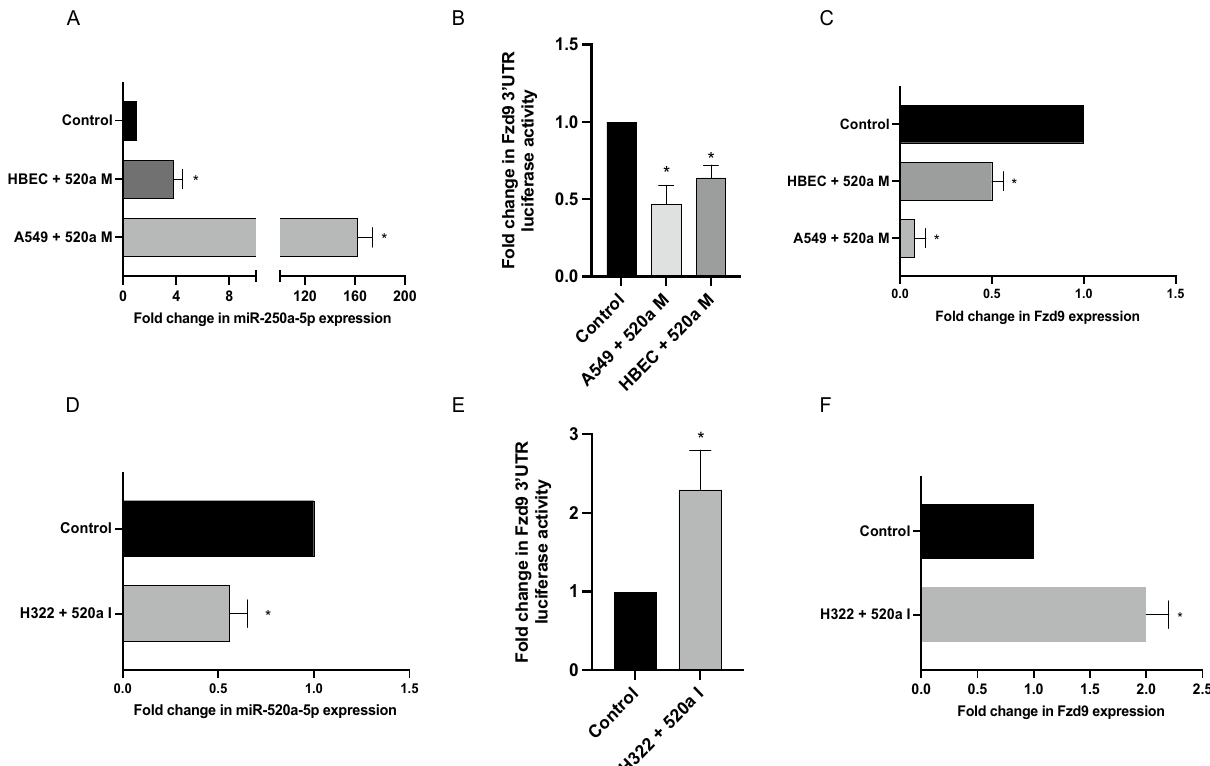
Figure 2. miR-520a-5p inhibits activity of the FZD9 3’UTR. miR-520a-5p expression ( A ), FZD9 3’UTR luciferase activity ( B ), and FZD9 expression ( C ) in FZD9 positive HBEC and A549 cell lines after transfection of a miR-520a-5p mimic and control. miR-520a-5p expression ( D ), FZD9 3’UTR luciferase activity ( E ), and FZD9 ( F ) in FZD9 negative H322 cell line after transfection of a miR-520a-5p inhibitor and control. Luciferase activity was measured in duplicate and shown relative to a control for each cell line. miRNA and mRNA expression were measured in triplicate by qPCR, normalized to RNU6 or GAPDH, and shown relative to control for each cell line. 520a M, miR-520a-5p mimic; 520a I, miR-520a-5p inhibitor. * p <